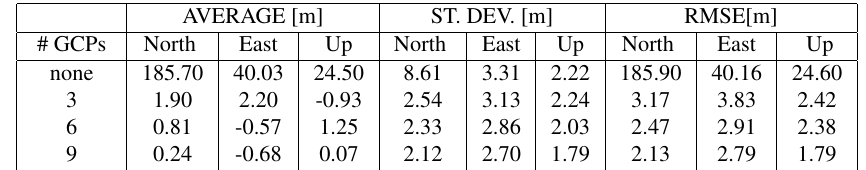
Table 1: Results of SISAR for Merano stereo pair using the radargrammetric rigorous model